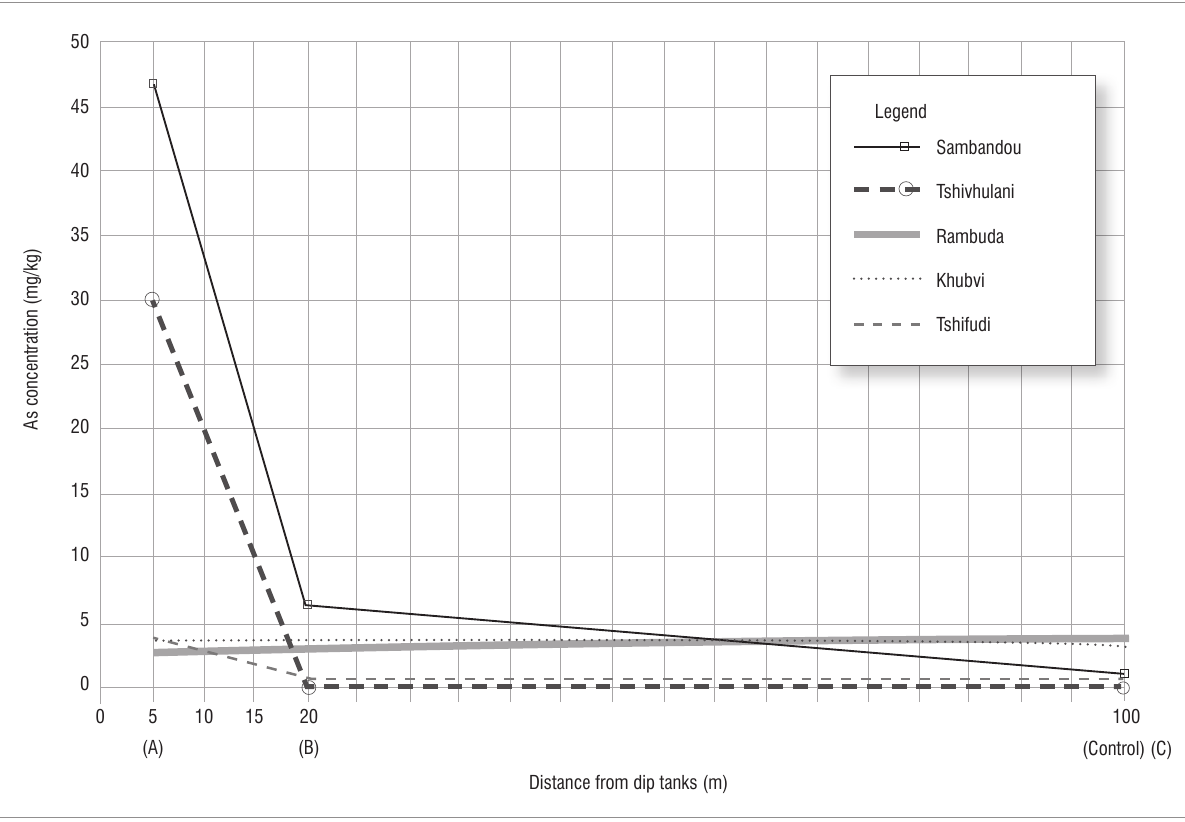
Figure 3: Arsenic concentration in soil at 5-m, 20-m and 100-m distances from dip tanks at five sites in the Vhembe district, Limpopo Province, South Africa.